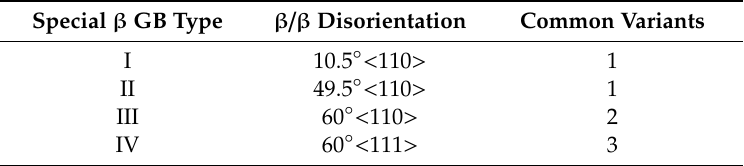
Table 1. Special disorientations for which two β grains share common variants (the number of common variants is also